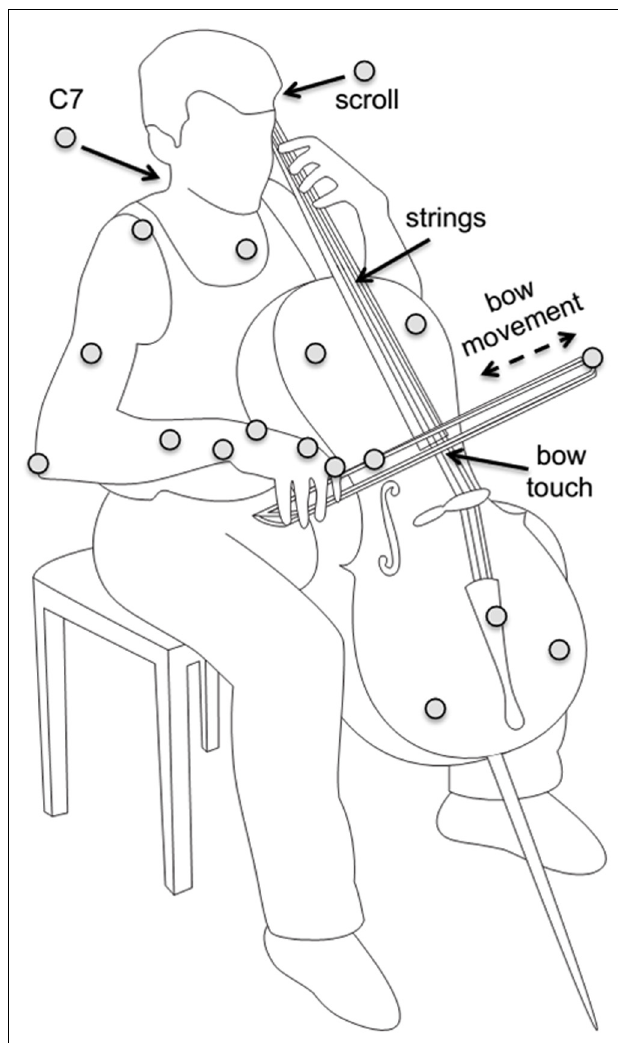
FIGURE 1 | Illustration of setup, instrument, and task. Marker positions are indicated as gray circles. Reproduced with permission fromVerrel etal. (2013a). Coordination of degrees of freedom and stabilization of task variables in a complex motor skill: expertise-related differences in cello bowing (Verrel etal.,